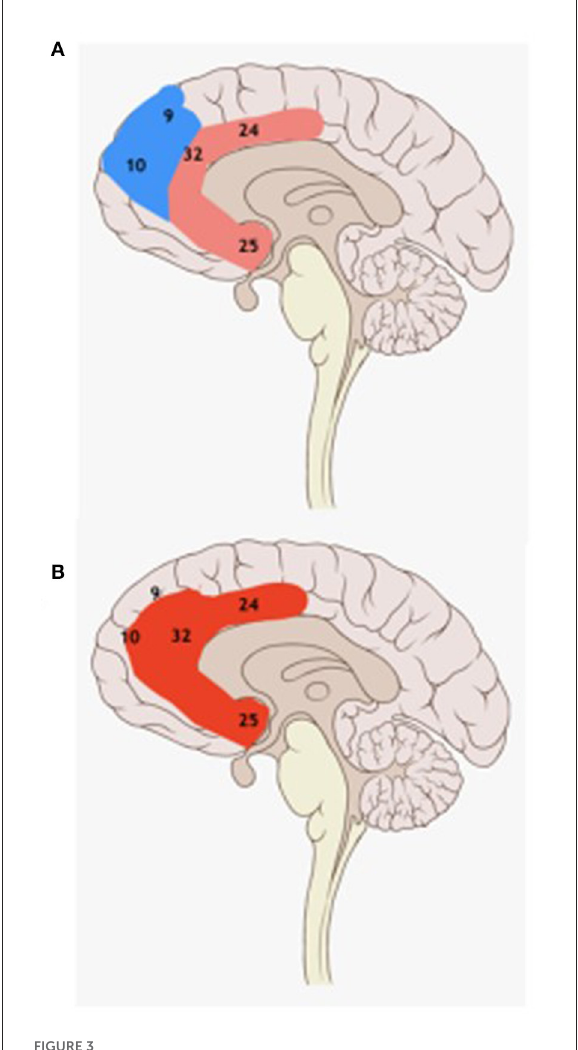
FIGURE3 Schematic drawing of the medial brain surface with Brodmann areas. Pink: prefrontal lobe, light red: the pyramidal system (A) ; red: the anterior cingulate area (Br. 24, 25, 32) (B) . There is a dissociation during DOA episodes between the blue fronto-dorsal cortex (in partial sleep) and the red anterior cingulate cortex (in partial wakefulness). SHE seizure onset zones of successfully operated SHE patients frequently overlap with DOA episodes’ activated red anterior cingulate